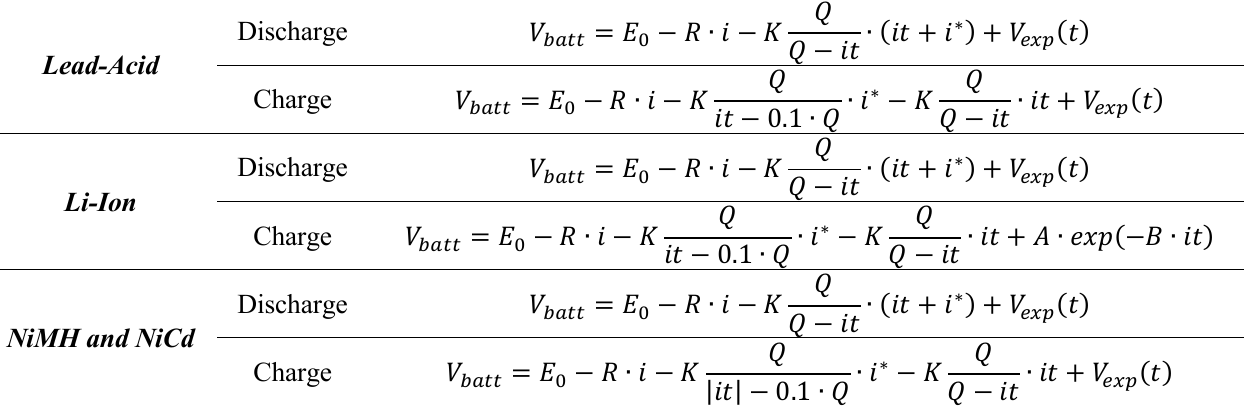
Table 1. Charge and discharge equations for the four types of